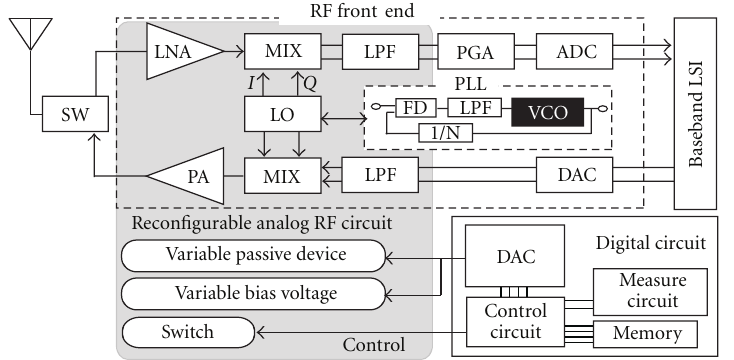
Figure 1: Concept of the reconfigurable RF circuit design.